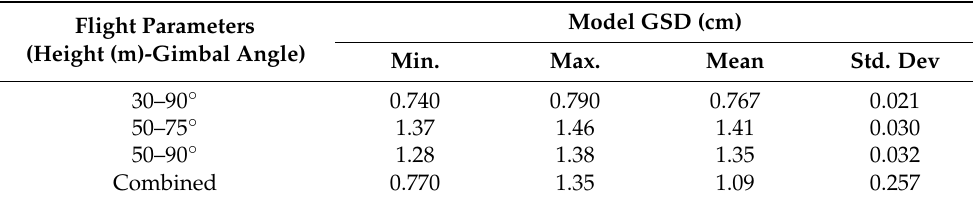
Table 5. Model GSD by flight parameters used in flights (including both fields on all four sampling days).